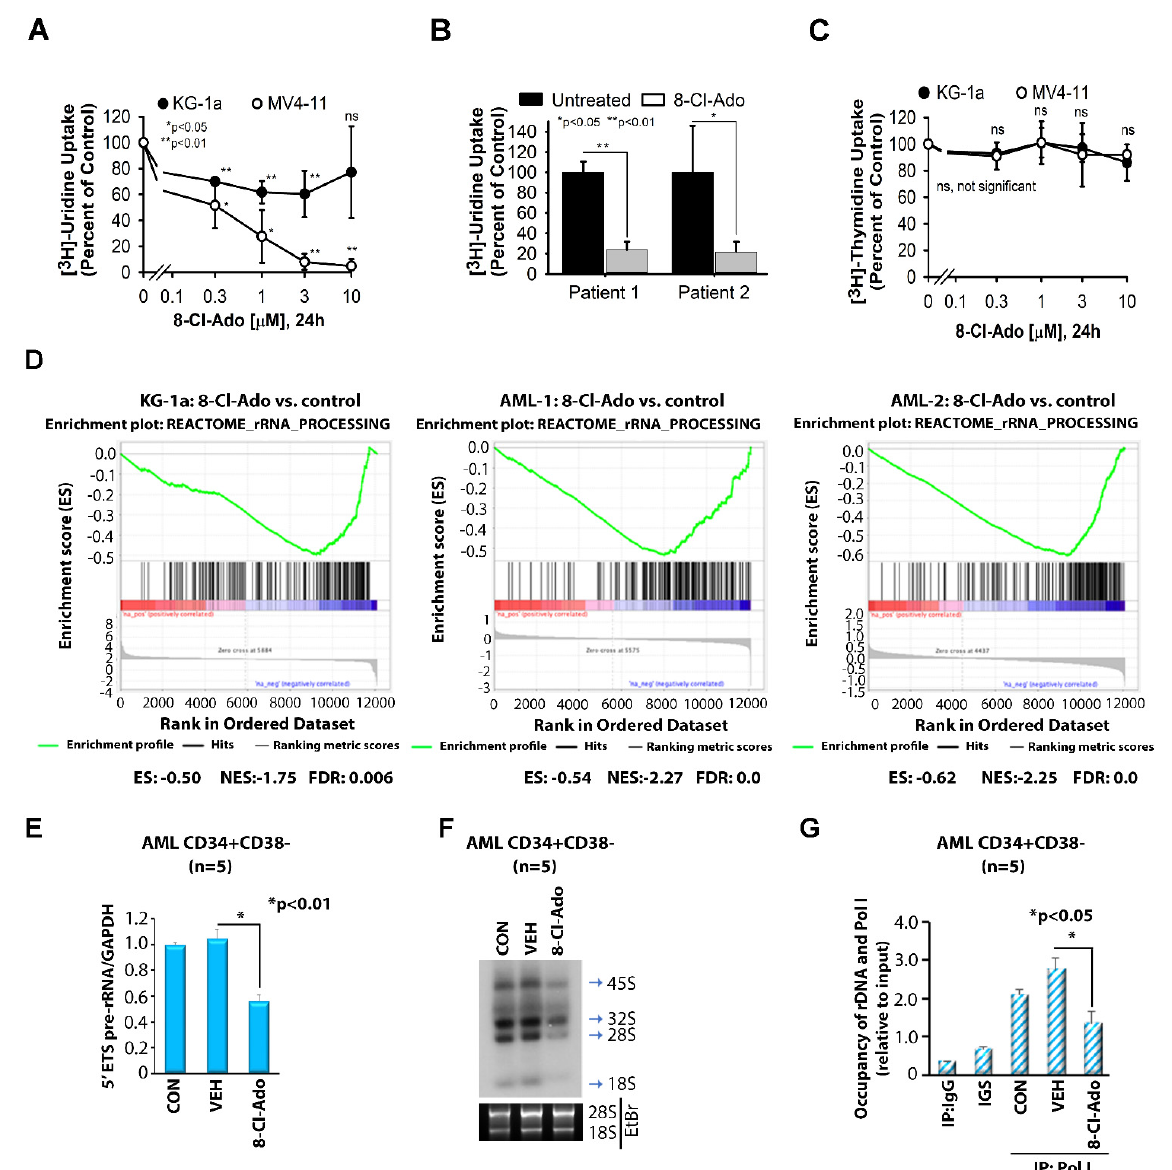
Figure 1. Regulation of rRNA synthesis by 8-Cl-Ado. ( A , B ) Effect of 8-Cl-Ado on RNA synthesis in AML cells lines ( A ) and primary AML blast cells ( B ). Cell lines KG-1a and MV4-11 were incubated with 0, 0.3, 1, 3 or 10 μ M 8-Cl-Ado for 24 h. Primary blast cells from 2 patients were incubated with or without 10 μ M 8-Cl-Ado for 24 h. In the last hour, [ 3 H]-uridine was added to measure uptake into newly synthesized RNA. ( C ) Effect of 8-Cl-Ado on DNA synthesis in AML cell lines KG-1a and MV4-11. Cells were incubated with 0, 0.3, 1, 3 or 10 μ M 8-Cl-Ado for 24 h. In the last 3 h, [ 3 H]-thymidine was added to measure uptake of newly synthesized DNA. n = 1 (in triplicate). Error bars = standard error. ( A – C ) n = 1 (in triplicate, KG-1a; in duplicate, MV4-11 and primary AML). ( D ) Gene set enrichment analysis (GSEA) graphs of genes involved in rRNA synthesis upon treatment of KG-1a and two primary AML cells with 500 nM 8-Cl-Ado for 24 h. n = 2. ES enrichment score, NES normalized enrichment score, FDR false discovery rate. ( E – G ) LSC-enriched blasts ( n = 5) were treated with vehicle control (VEH) or 500 nM 8-Cl-Ado for 24 h. RNA was extracted for measurement of 5 ′ ETS pre-rRNA ( E ) or for radioactive labeling with [ 32 P] ( F ). ChIP assay was performed to measure the level of Pol I recruited to the rDNA promoter. Original blots see Supplementary File S1 ( G ). GAPDH ( E ) or 10% input ( G ) was used as the internal control. ( E , G ) n = 2, in triplicate. CON, control; VEH, vehicle; 8-Cl-Ado,